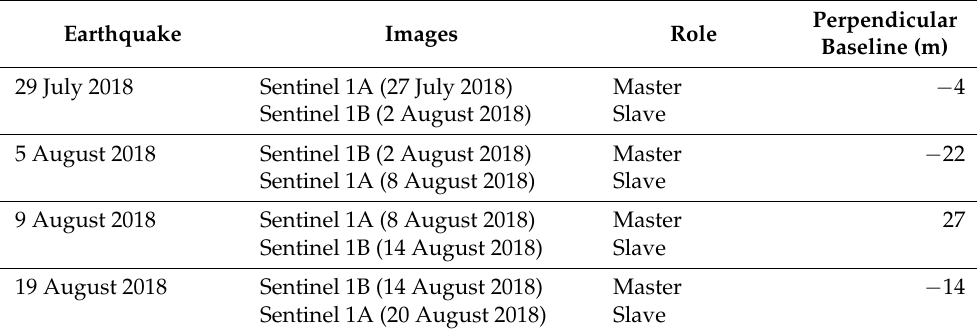
Table 1. List of Sentinel 1 Satellite imageries corresponding to earthquakes on 29 July 2018, 5 Au-